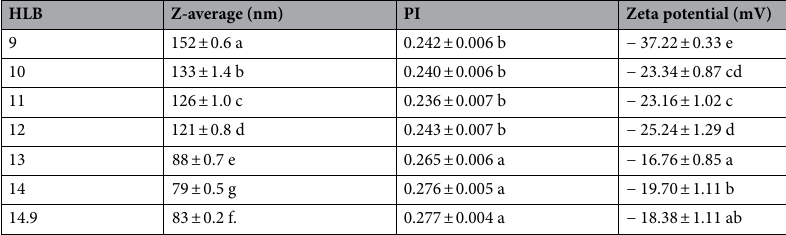
Table 3. Z-average (particle diameter), PI, and zeta potential of CEO-based nanoemulsions. The optimized formulation was produced at HLB 14. Means ± standard deviations. Means with different letters within a column are significantly different ( p <